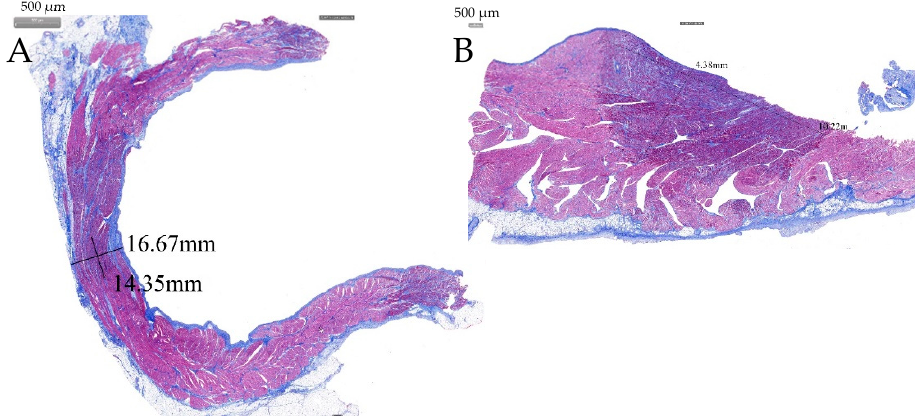
Figure 9. Masson’s trichrome stain. ( A ) In a longitudinal section along the RSPV lesions, a transmural lesion is seen in the RSPV. ( B ) Section demonstrating non-transmural lesions in the SVC.